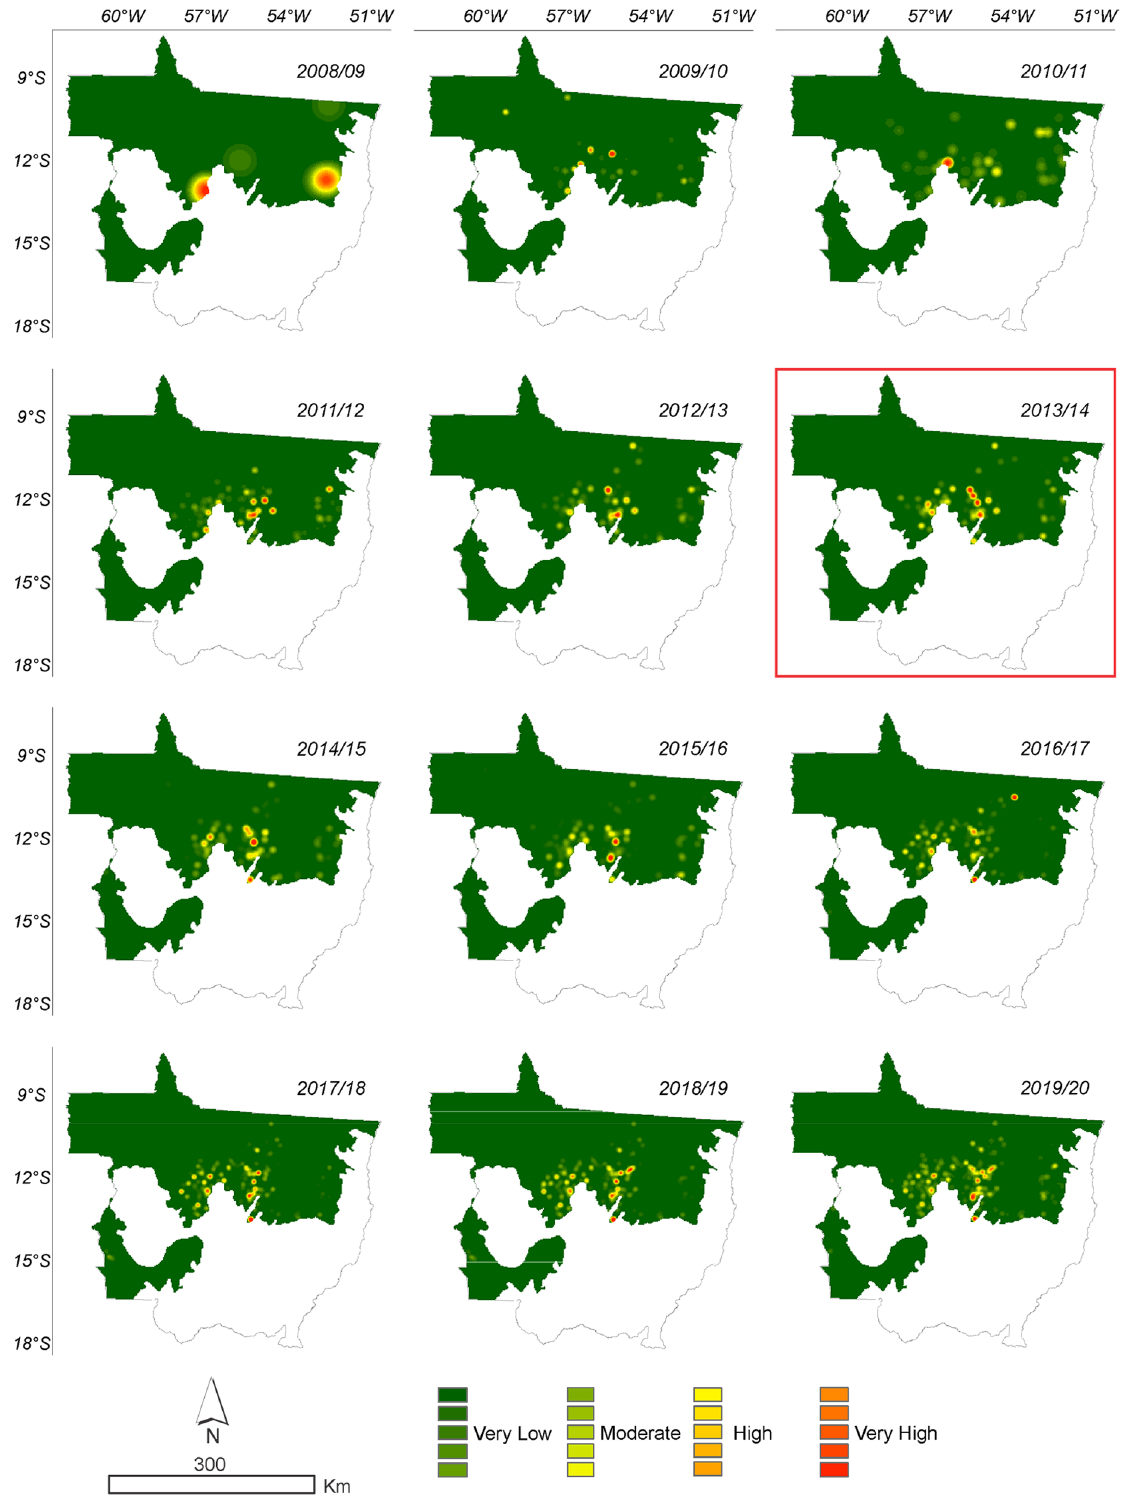
Figure 13. Density of deforestation caused by soybean in Amazonia biome in the State of Mato Grosso from 2008 to 2019 with data from ImazonGeo. The year highlighted with red square corresponds to the likely point of change in the time series identified by the Pettitt test (Table